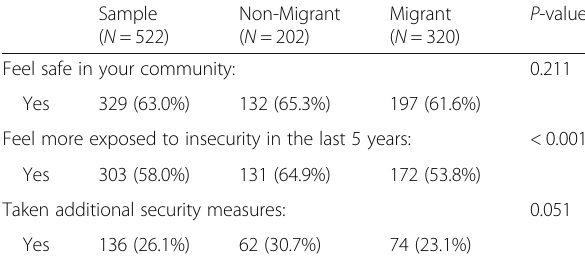
Table 7 Personal capital: Safety and threats to security/wellbeing Sample Non-Migrant ( N = 522) ( N = 202)